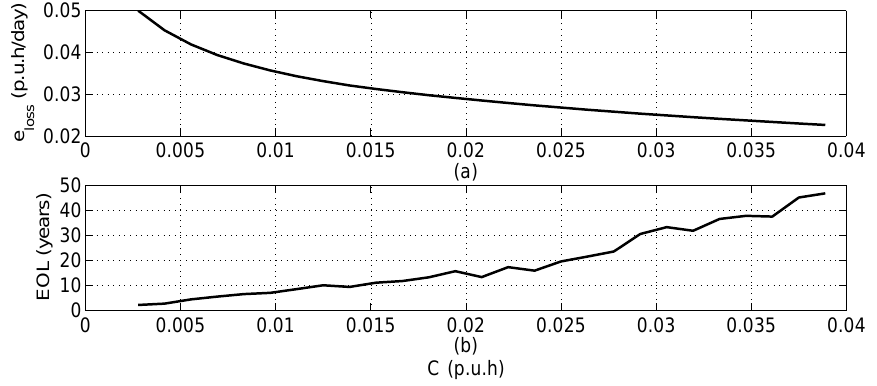
Figure 21. BESS sizing results for Puerto Rican case considering a whole year of transient results data: ( a ) Daily energy losses per BESS capacity; and ( b ) EOL per BESS